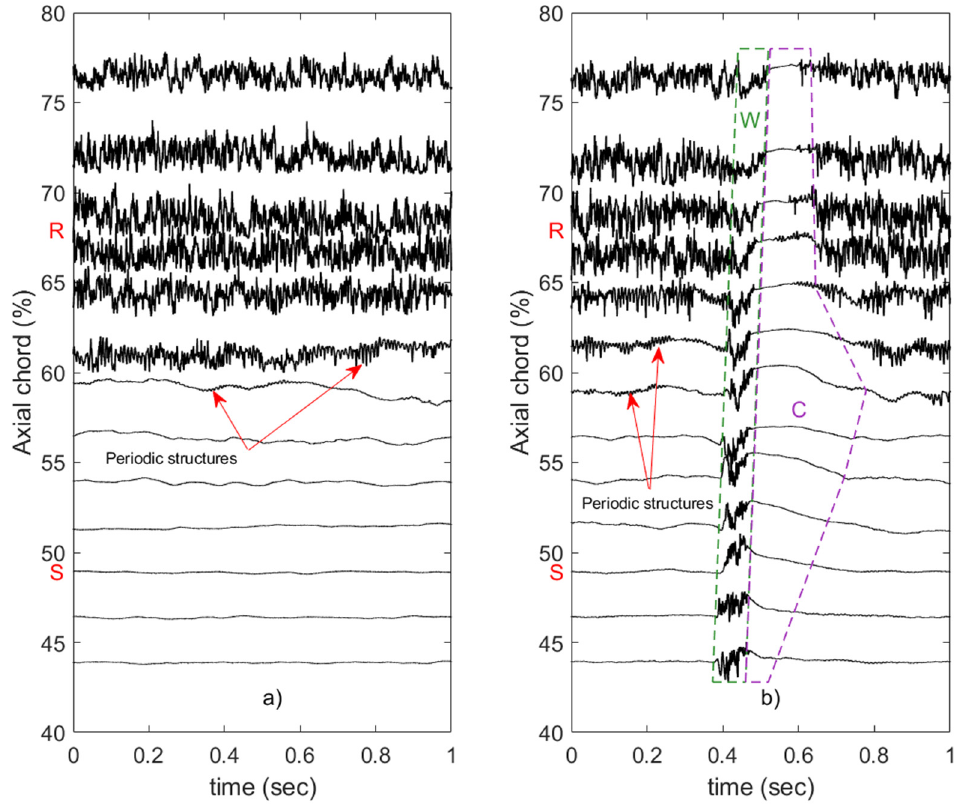
Figure 6. Development of the time series of the velocity signals with distance for ( a ) steady-inlet and ( b ) wake-inlet. S and R represent the approximate locations of flow separation and reattachment from the current measurements.